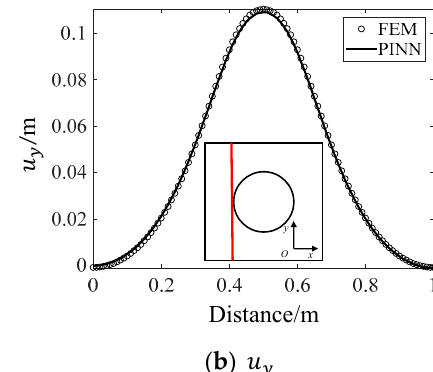
Figure 7. Comparison of the obtained strain fields ( left : FEM; right : PINN) of the in-plain stretching- related solid mechanics problem.